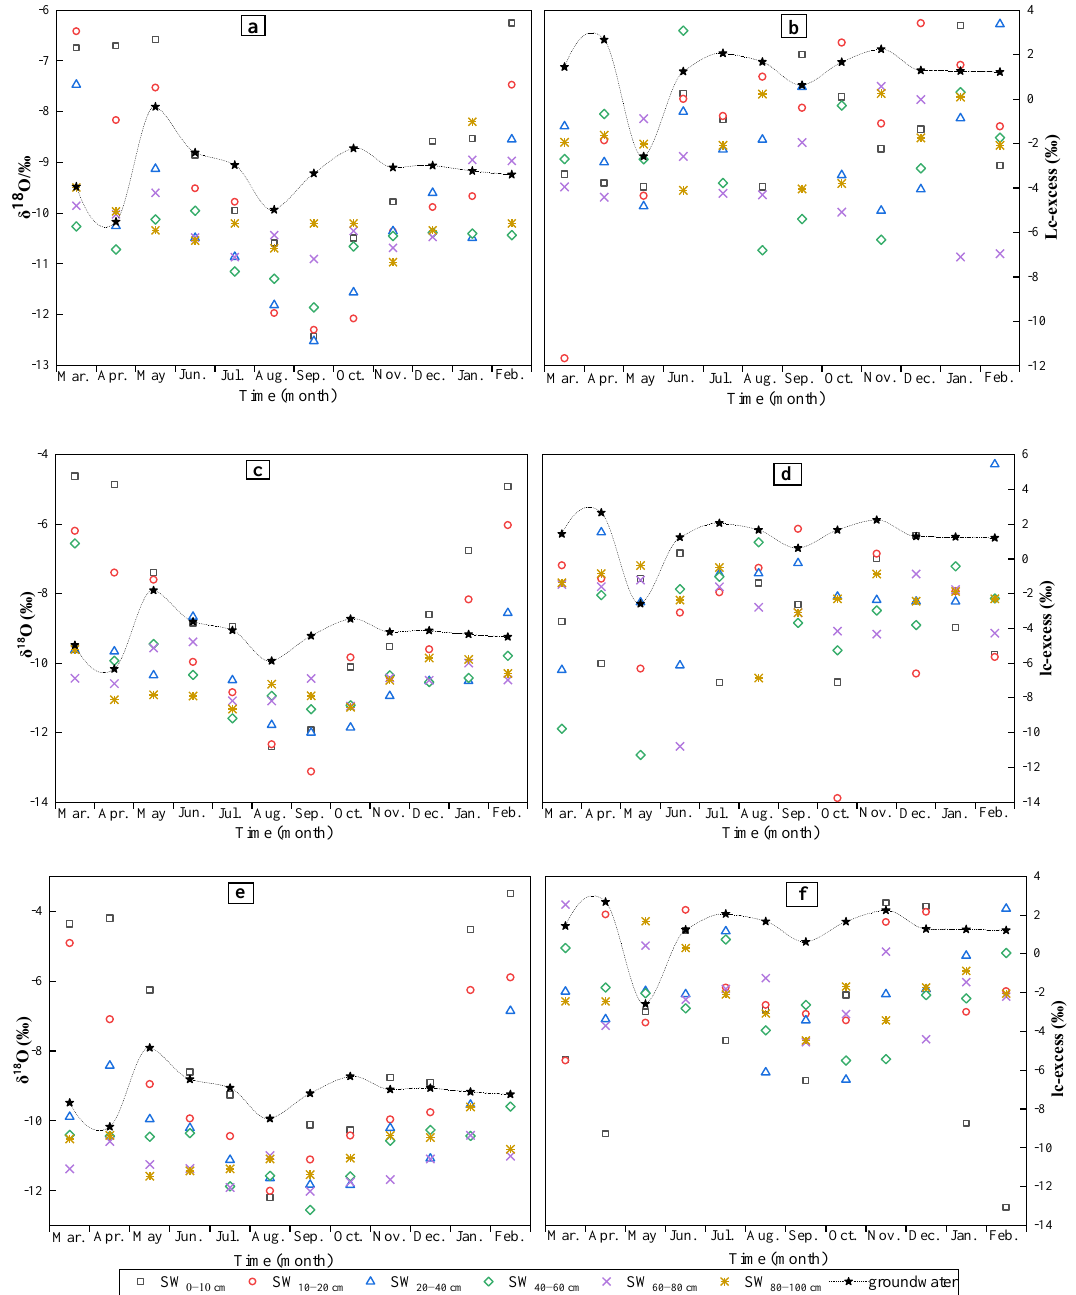
Figure 4. Temporal variations of δ 18 O and lc-excess in soil water at different depths and groundwater (Arbor land: ( a , b ); Shrubland: ( c , d ); Grassland: ( e , f )).